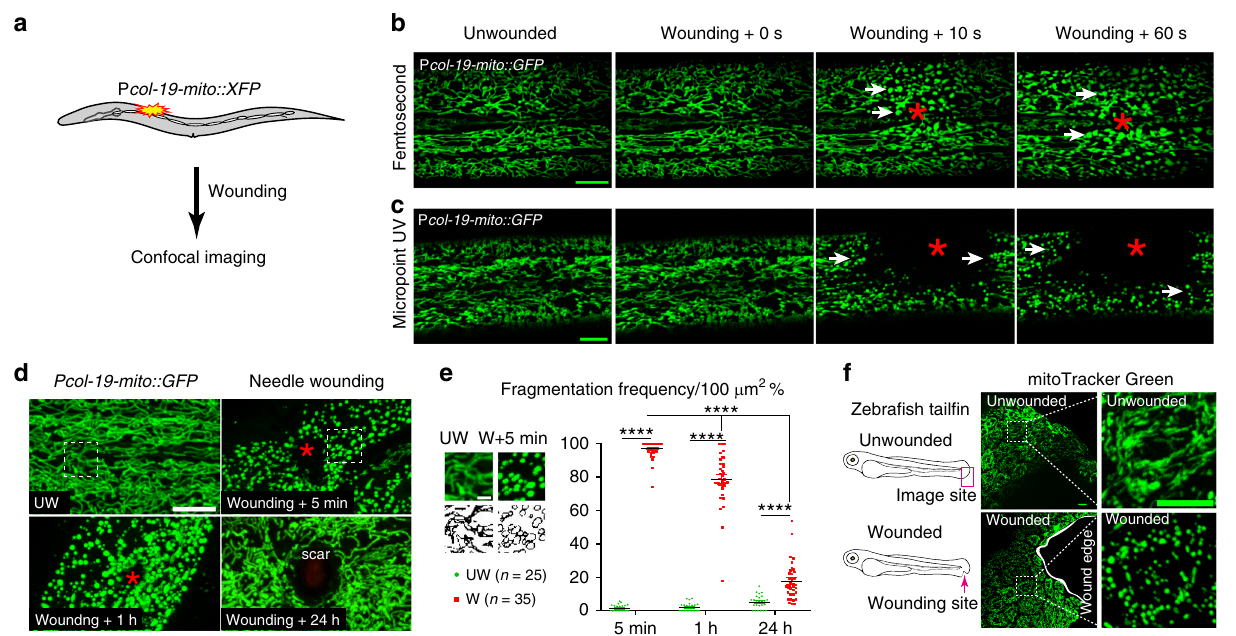
Fig. 1 Wounding triggers rapid and reversible mitochondrial fragmentation. a Experimental design to investigate the mitochondrial response to epidermal wounding (laser or physical damage) in C. elegans . Mitochondria were labeled with matrix targeting sequence from cox 8 (mito) fused with XFP (including P col-19-mito::GFP(juEx4796) , P hpy-7( y37a1b.5) -mito::GFP(yqIs157) 70 , P col-19-mito::mKate2(zjuSi47) , or P col-19-mito::dendra2(juSi271) ). b , c Laser wounding induces mitochondrial fragmentation in the epidermis. Representative confocal images of the epidermal mitochondrial network before and seconds after wounding by femtosecond laser ( b ) (see also Supplementary Movie 1, N = 5 independent experiments) and Micropoint UV laser ( c ) (see also Supplementary Movie 2, N = 7 independent experiments). Pcol-19-mito::GFP(juEx4796) was used to label mitochondria. We de fi ne mitochondrial fragmentation as a change from the interconnected tubular structure network to a rounded shape. d Mechanical needle wounding causes fragmentation of epidermal mitochondria, which return to normal morphology 24 hours after wounding except for a scar region at the center of the wound site. Representative confocal images of epidermal mitochondria before and after needle wounding. N = 3 independent experiments. Pcol-19-mito::GFP(juEx4796) was used to label mitochondria. Red asterisks in b – d indicate the wound site. White dashed squares indicate the zoom-in images for panel e . Scale bars b – d , 10 μ m. e Quantitation of mitochondrial fragmentation frequency after needle wounding, measured in 100 μ m 2 regions of interest (white dash square in panel d ) 10 μ m adjacent to the wound site. Top panel shows enlarged images of mitochondria in unwounded (UW, n = 25) and wounded (W, n = 35) epidermis. Scale bars, 5 μ m. Bars indicate mean ± SEM. **** P < 0.0001, Two-tailed unpaired t -test for wounded animals. Source data are provided as a Source Data fi le. f Wounding induce mitochondrial fragmentation in zebra fi sh tail fi n. Left, experimental design for zebra fi sh tail fi n wounding, 3 dpf larvae were fi rst stained with mitoTracker Green for 2 h and then were wounded using needle. N = 3 independent experiments. Right, representative confocal image of mitochondria at the edge of zebra fi sh tail fi n, Scale bar, 10 μ closure 1 hour after injury (Fig. 2j). In contrast, the expression of G-DEG in muscles did not affect epidermal wound closure (Fig. 2j). Epidermal speci fi c expression of fzo-1 rescued frag- mented mitochondria and suppressed faster wound closure in fzo- 1(tm1133) animal (Fig. 2c,d). However, muscle expression of fzo-1 could not suppress the enhanced wound closure in fzo-1(tm1133) animal (Fig. 2d). Collectively, these results show that mitochon- drial fragmentation acts cell-autonomously in wound closure. WIMF is independent of canonical mitochondrial fi ssion reg-